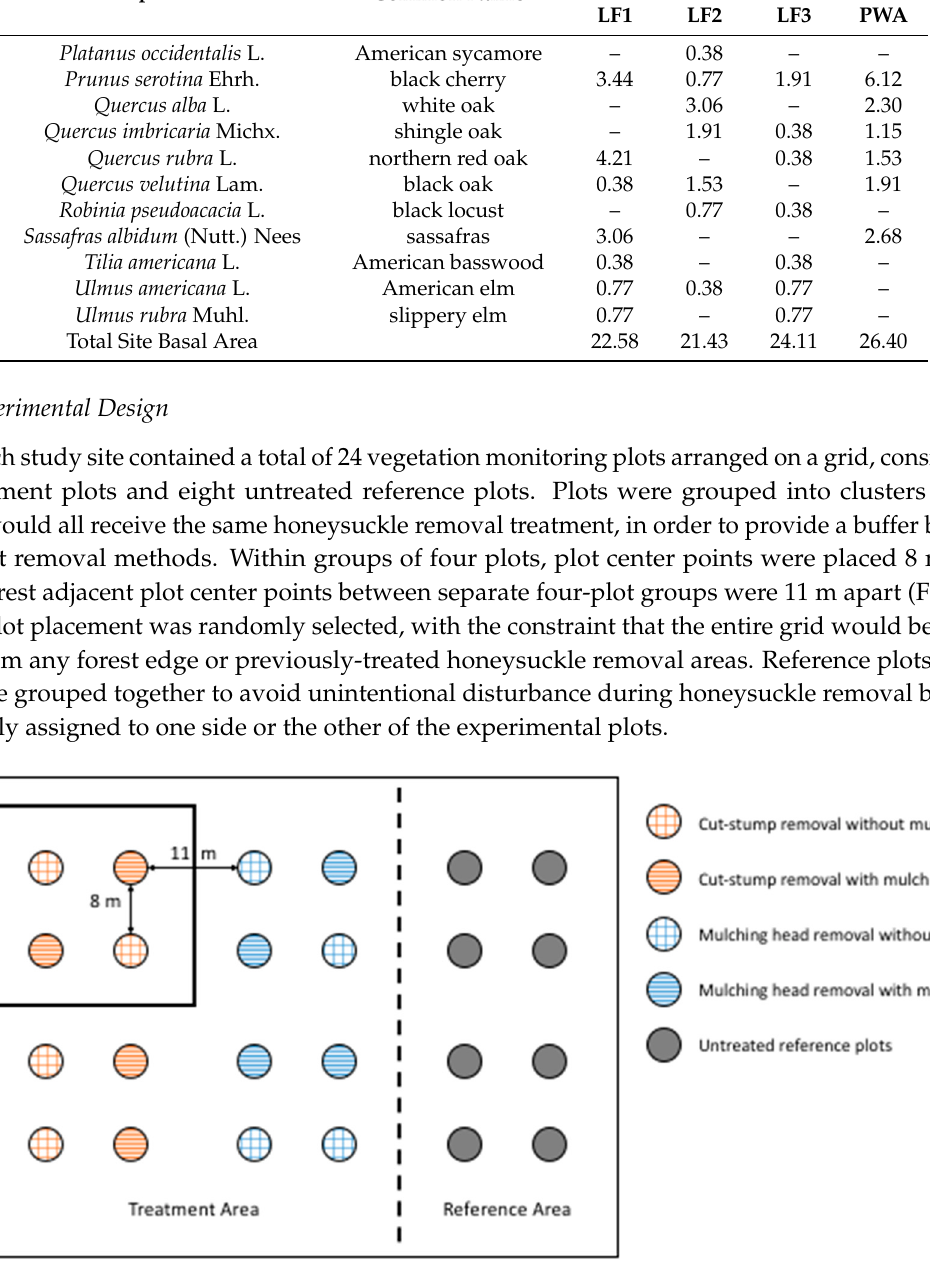
Figure 1. Schematic of an example site layout. Circles represent plot center points, with fill colors indicating different removal methods (cut-stump or mulching head). Removal methods were randomly assigned to each four-plot grouping (e.g., black square top-left) to avoid incidental impacts of the mulching head on non-target plots. Mulch cover (presence/absence) is represented by different fill patterns and was randomly assigned to two plots within each four-plot group. Circles with solid gray fill indicate reference plots (to the right of the dashed line). Spacing between plots in the same group was 8 m and spacing between plots of different groups was 11 m.